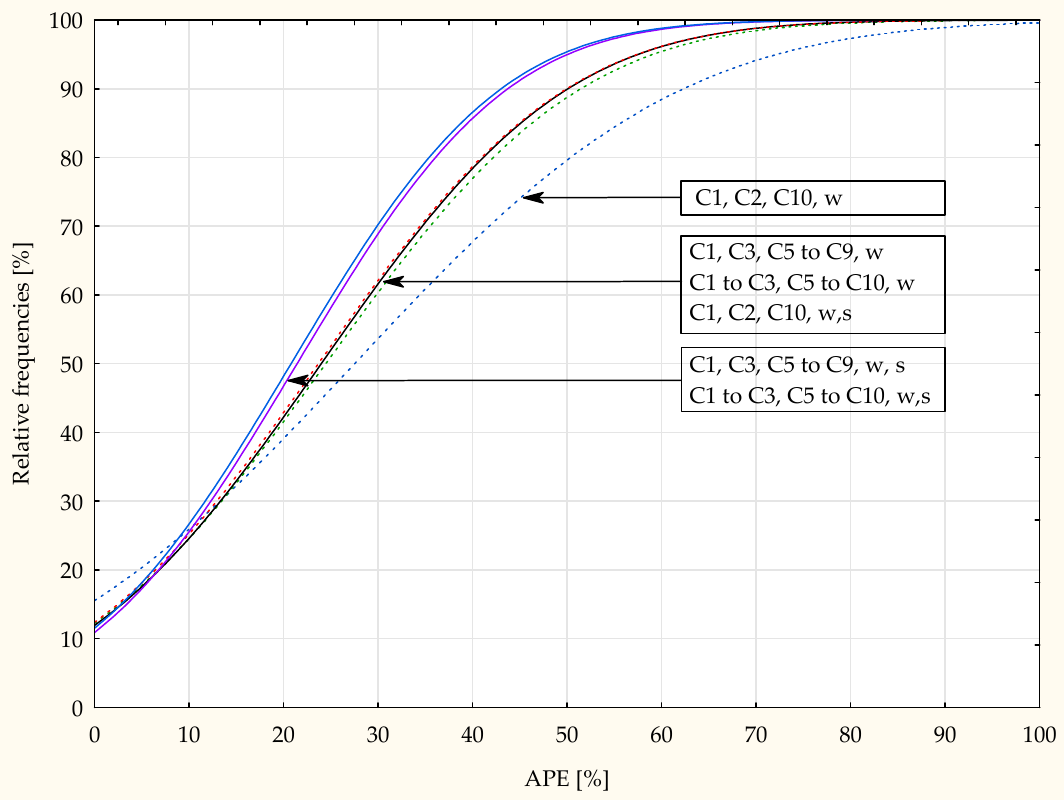
Figure 9. Assessment of the quality of the developed models of the total waste accumulation indicator from households for determined clusters in a varied system of input variables.